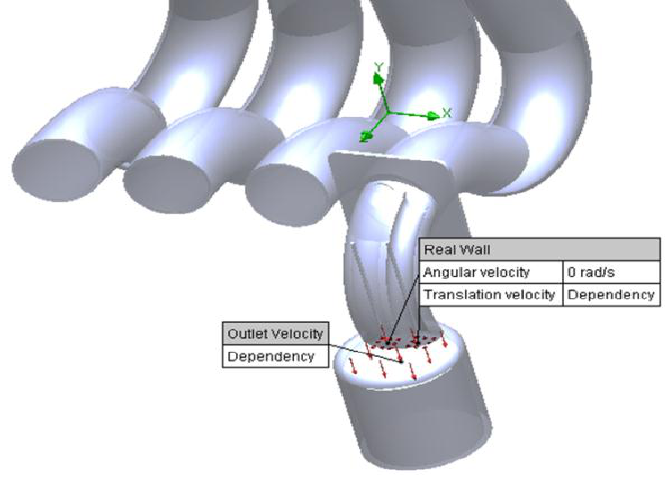
Figure 3. Boundaries conditions on piston and valves.